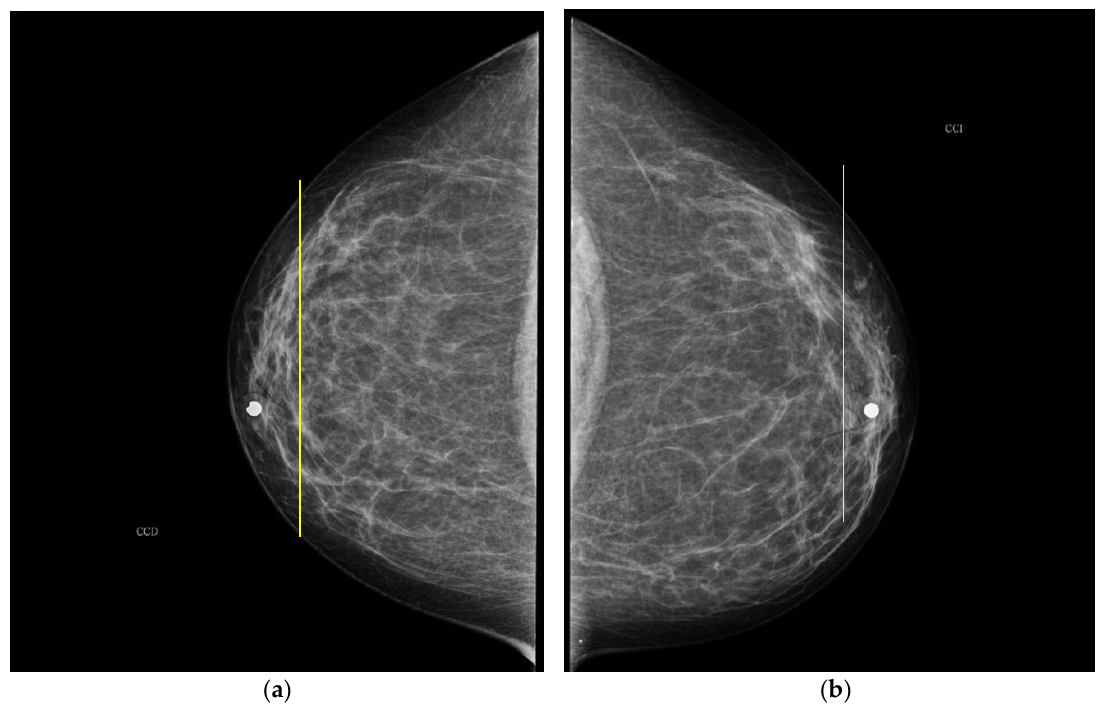
Figure 8. CC mammogram images of participant 5 and relative electrode ring position (yellow vertical line): ( a ) right breast; ( b ) left breast.